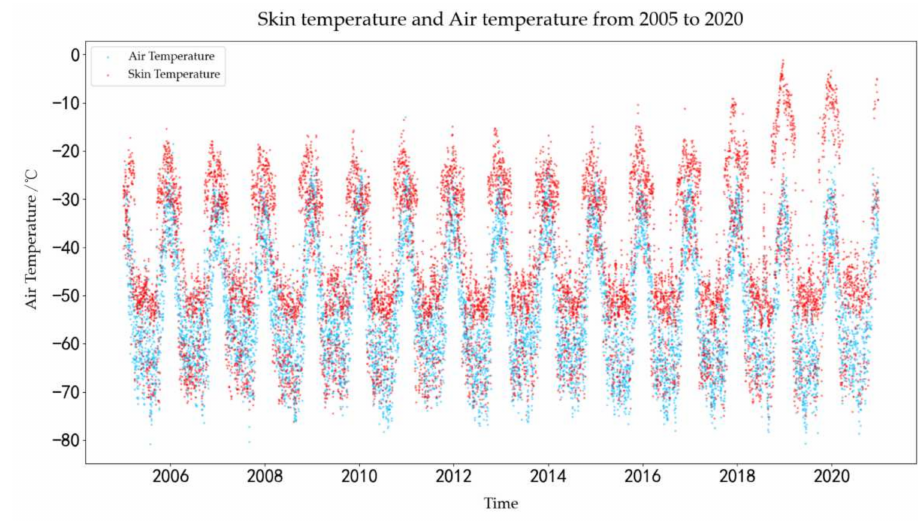
Figure 3. Skin temperature and air temperature at Dome A obtained from AVHRR and